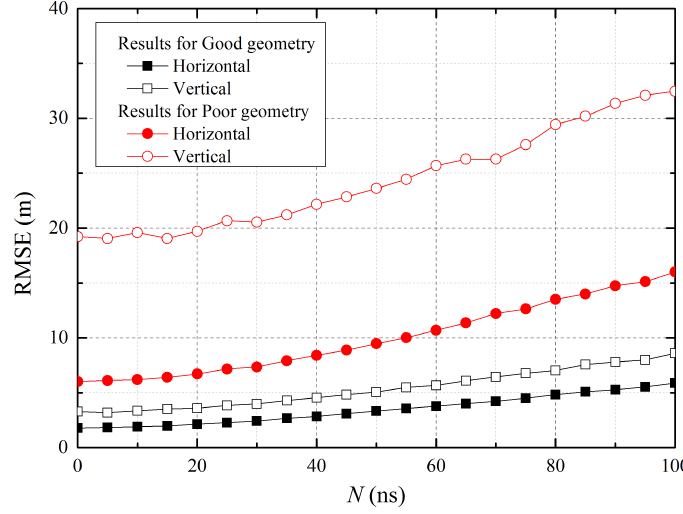
Figure 10. RMS error of the user according to clock